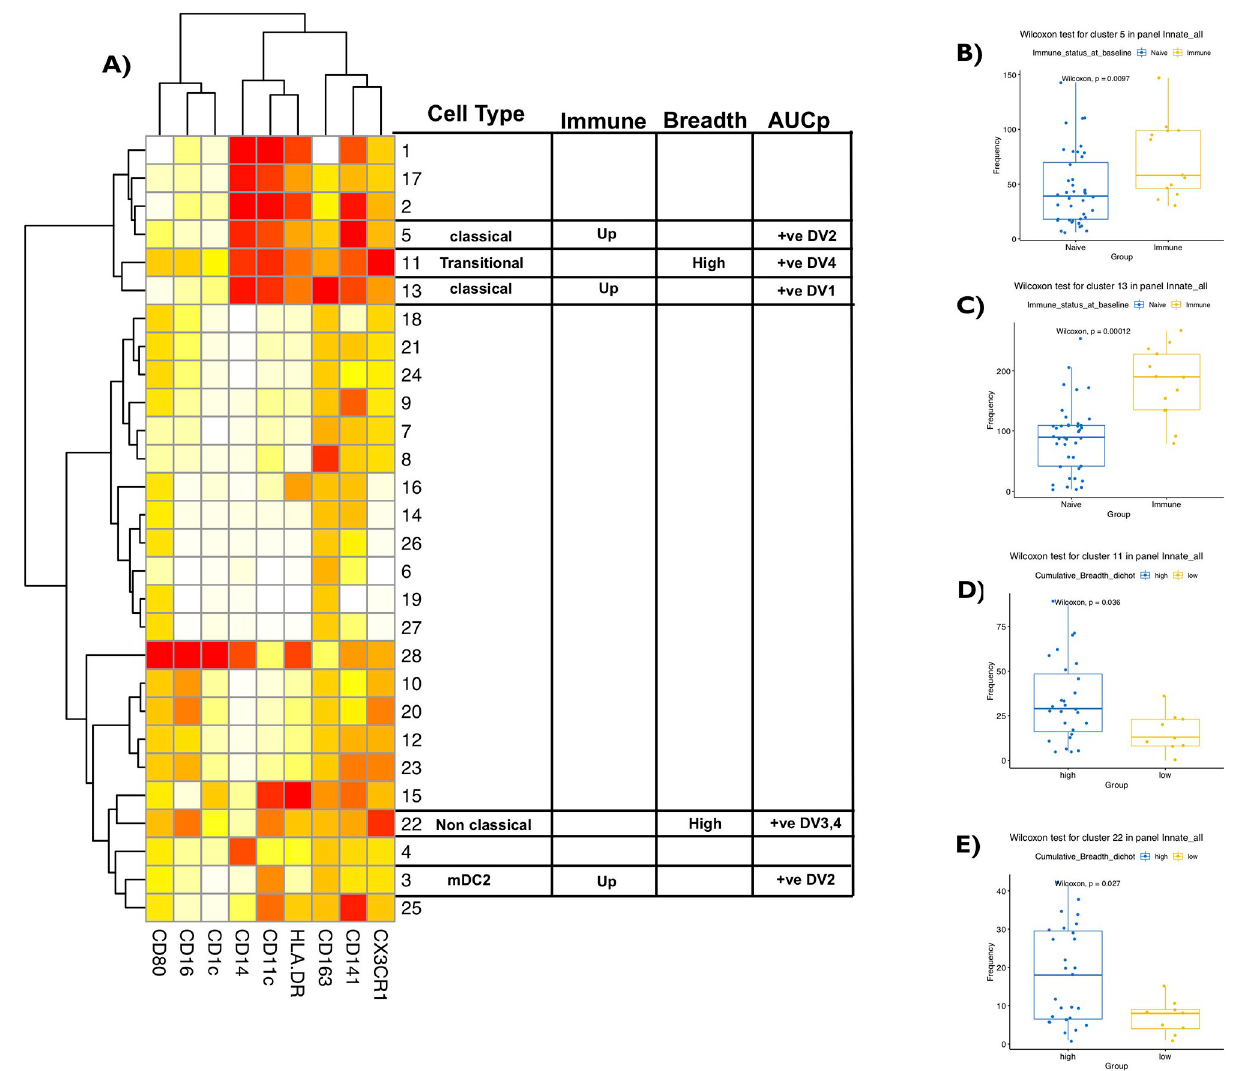
Fig 6. Monocytes correlate positively with both the AUCp and the breadth of the response. (A) Heatmap of the 28 different clusters expressing different phenotypes using the optimized innate cell panel are shown with markers in the x axis. Among them are clusters 3, 5,11,13 and 22 that represent type 2 myeloid dendritic cell, classical monocyte, transitional monocyte and non classical monocyte. The table identifies cell type, immune group pre-vaccination/baseline difference, breadth and neutralizing antibody titers (AUCp). Cells were gated on live cells and the expression was scaled and used to perform clustering which was visualized using t-Distributed Stochastic Neighbor Embedding (tSNE). Cell frequency per cluster/ per sample was derived and used for statistical testing between high and low breadth across subjects. Subjects who mounted neutralizing antibodies against all four serotypes (termed “high” breadth) were compared to subjects who mounted neutralizing antibodies against < 3 serotypes (termed “low” breath). Pre- vaccination/baseline subject samples were associated with breadth of the response and neutralizing antibody titers (AUCp) post vaccination. (B and C) Frequency of cluster 5 and 13 (classical monocytes) between Immune vs Na ï ve at pre-vaccination/baseline time point. (D) Representation of cluster 11 (transitional monocytes) pre-vaccination/baseline subject samples were associated with breadth of the response post vaccination . (E) Representation of cluster 22 (non-classical monocytes) pre-vaccination/baseline subject samples were associated with breadth of the response post vaccination. Before vaccination, seropositive subjects with existing antibodies to any of the four Dengue virus serotypes due to prior infection were referred to as (“Immune”) or seronegative subjects with no existing antibodies to any of the four Dengue virus serotypes were referred to as (“Na ï ve”). Paired non- parametric Wilcoxon test, 95% confidence was calculated for (B-E). Non-parametric Spearman Correlation with 95% confidence intervals was used for correlations with neutralizing antibody titers (AUCp column). Nominal p-values p < 0.05 were considered statistically significant. � p < 0.05, �� p < 0.01 and ��� p < 0.001. ���� p < 0.0001.